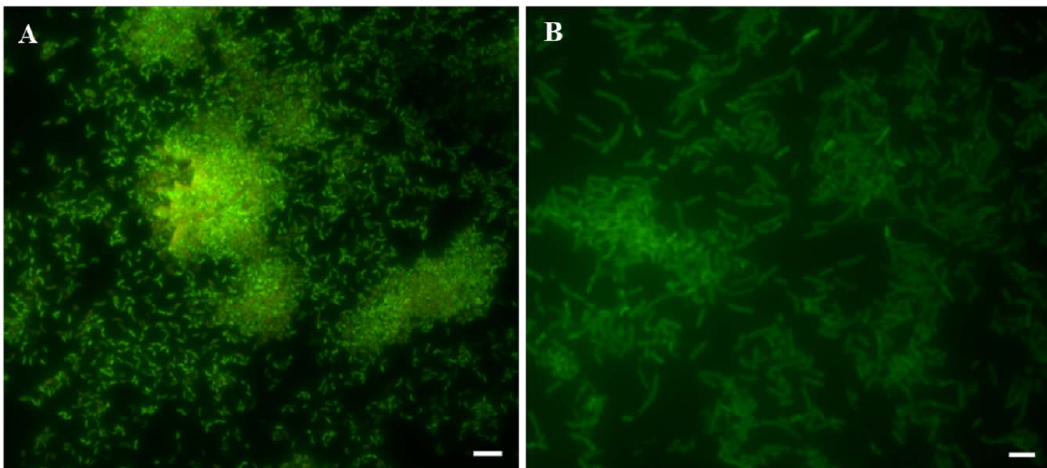
Figure 1. Microscopy representative images of biofilms developed by Helicobacter pylori ATCC 43629 after 48 h of incubation ( A ) and Lactobacillus reuteri DSM 17938 after 24 h of incubation ( B ). The biofilms were stained with Syto 9 (green fluorescence). Scale bar = 5 μm.